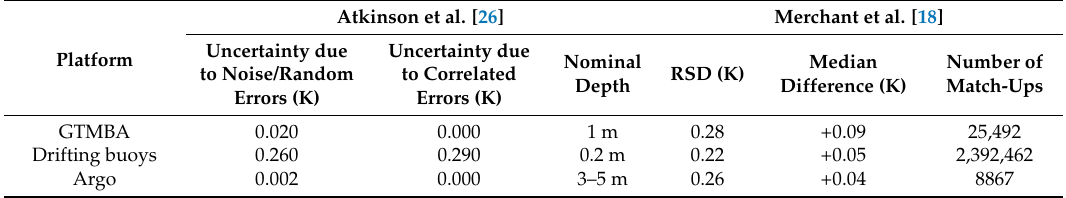
Table 1. Uncertainty characteristics and depth of the in situ observations following Atkinson et al. [26]. Also listed are the robust standard deviation of the differences between the ESA SST CCI product and listed platforms, the median difference and number of match-ups from phase 1 of the ESA SST CCI project